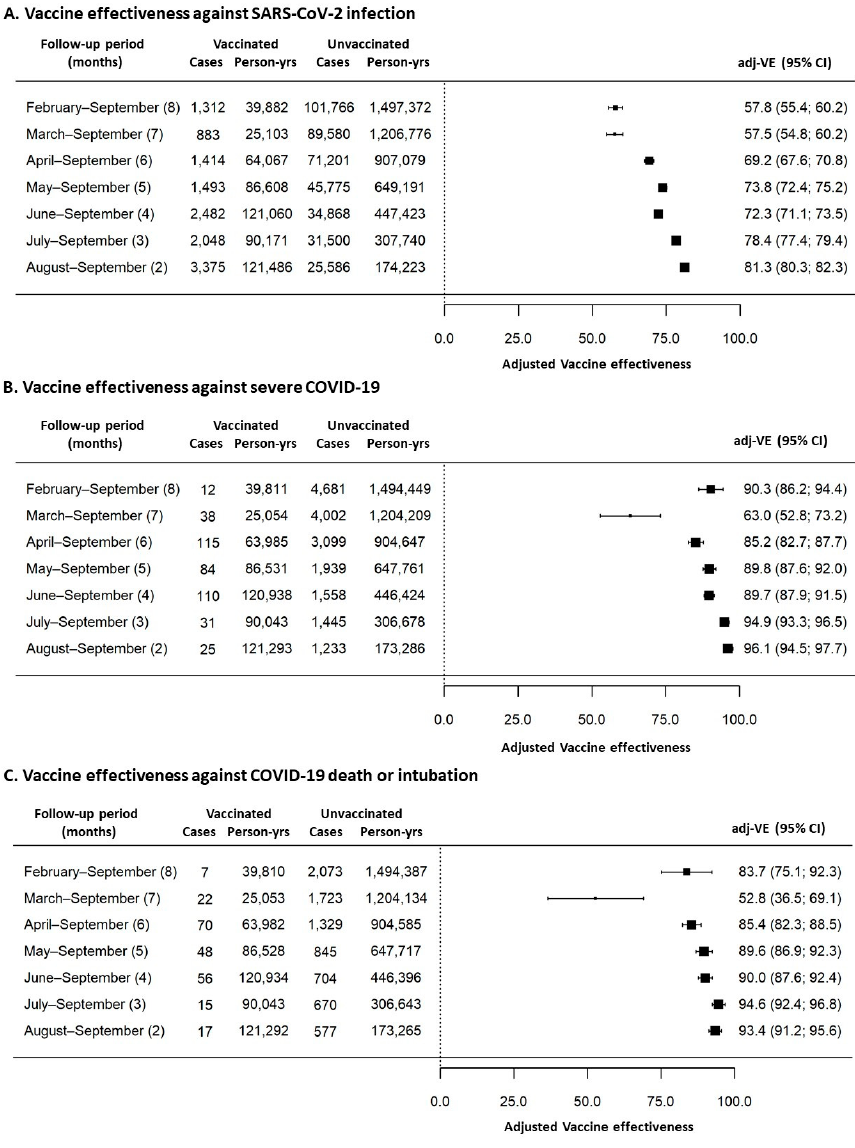
Figure 4. Vaccine effectiveness estimates after adjustment for age and sex according to the different assessed outcomes and follow-up periods. ( A ) Vaccine effectiveness against SARS-CoV-2 infection; ( B ) Vaccine effectiveness against severe COVID-19; ( C ) Effectiveness of vaccines against COVID-19 death or